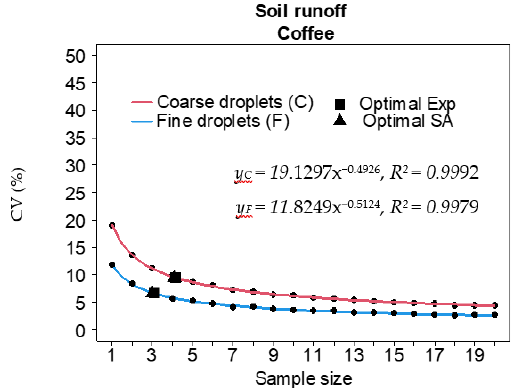
Figure 3. Coefficients of variation (CVs) as a function of the optimal sample size for soil runoff for two droplet classes, using two statistical models. Sample size for the number of Petri dishes; Parameters a and b significant ( p < 0.001) in all regressions; Exp: exponential model; SA: spatial autocorrelation model.